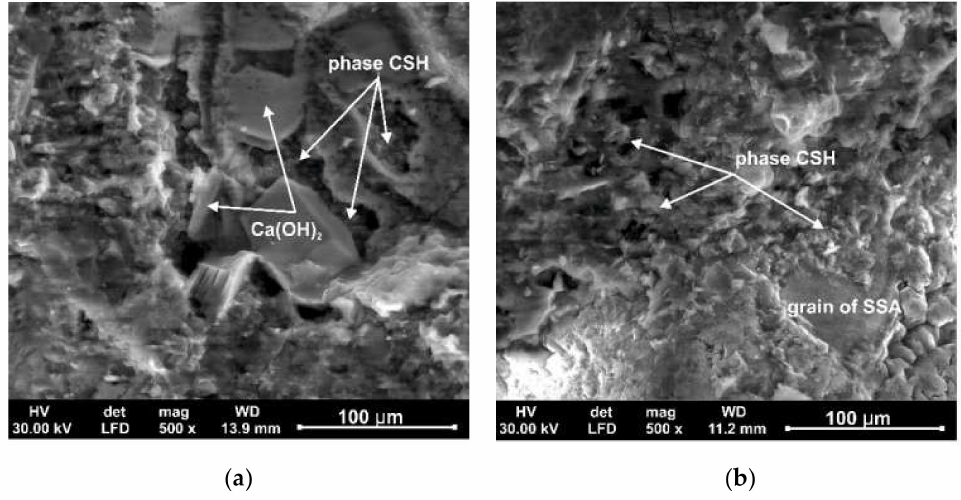
Figure 8. SEM microscopic image structures (500 × ): ( a ) OPC 42.5 R; ( b ) with sewage sludge ash after 7 days, magnification 500 ×